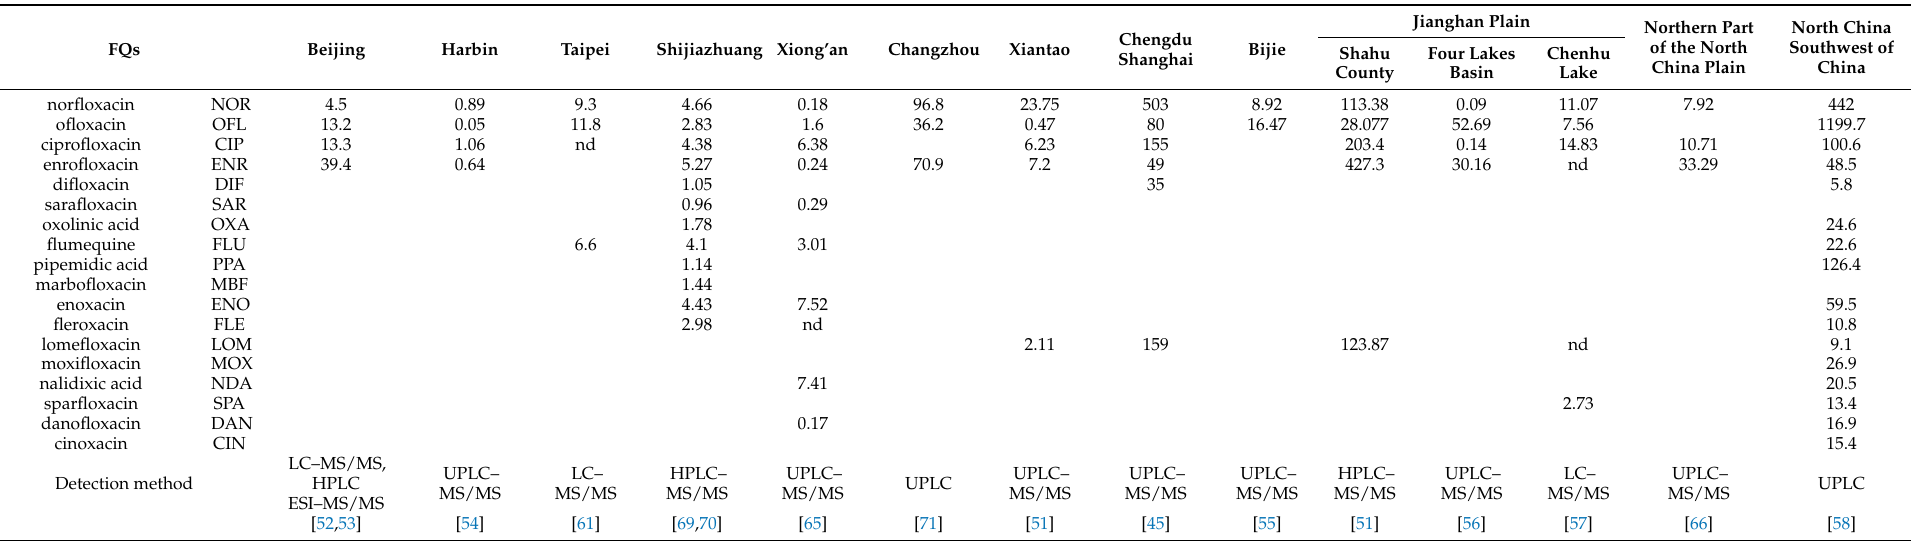
Table 3. FQs and their concentrations detected in groundwater of China (ng/L), and the detection method.